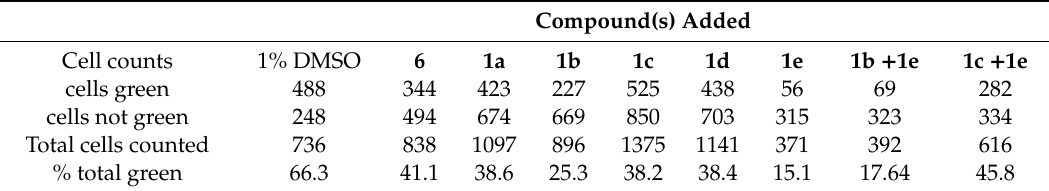
Table 4. Cell counts for microscopic images of DAF-FM diacetate incubated L. tarentolae and calculated percent of cells able to express nitric oxide (green).